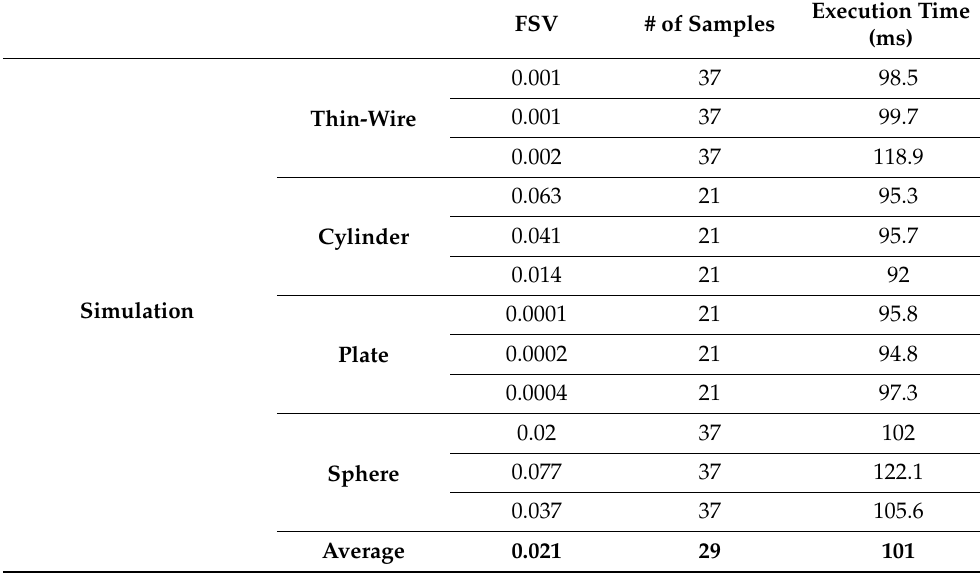
Table 2. Simulated scenarios’ FSV results for VCM, with execution time and the number of sam- ples